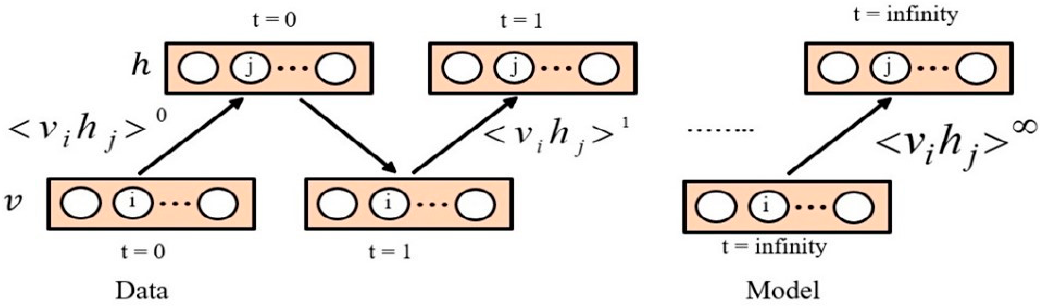
Figure 2. Gibbs Sampling to update all associated weights.